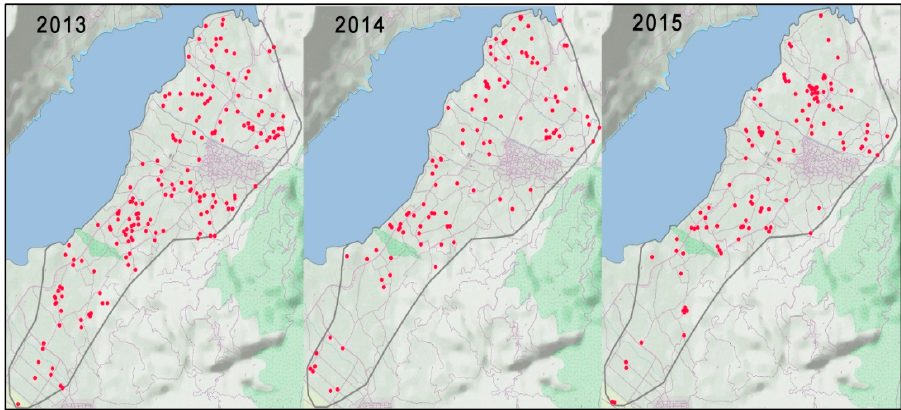
Figure 2. The randomly selected locations of the sampling points (in red) for each year.